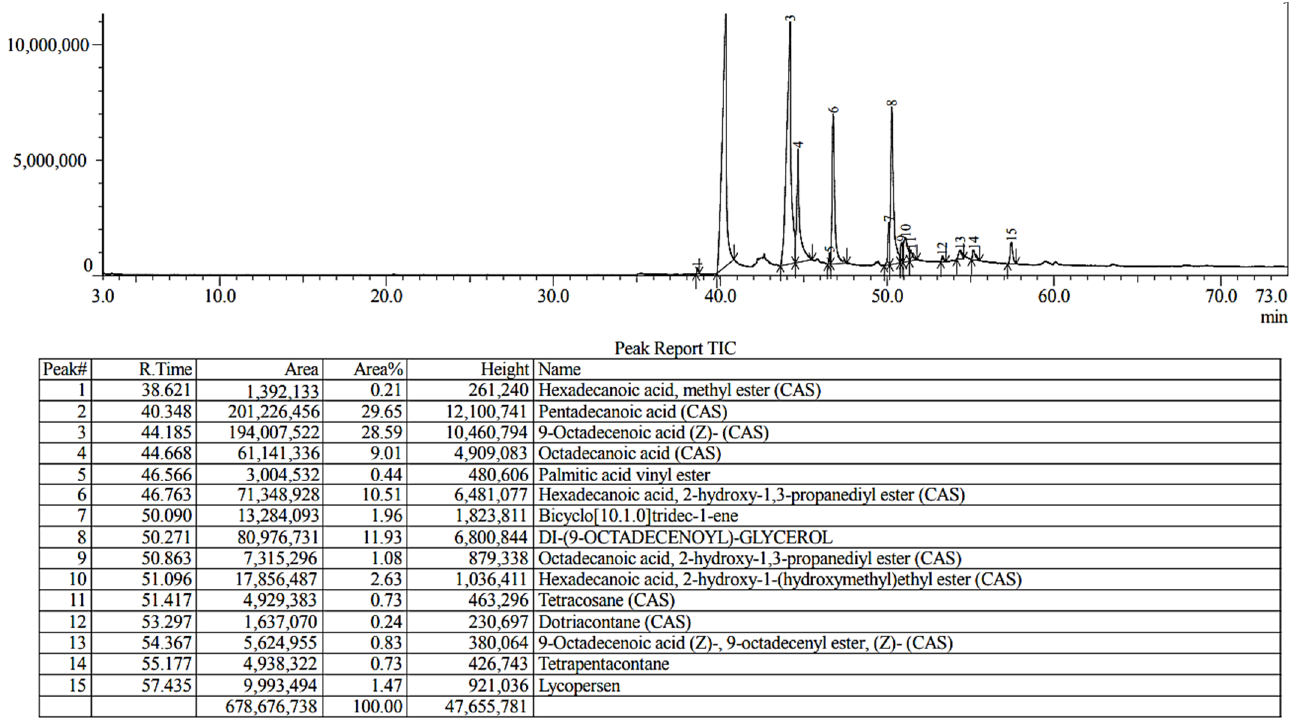
Figure 2. GC-MS chromatogram of CPO after fractionation.